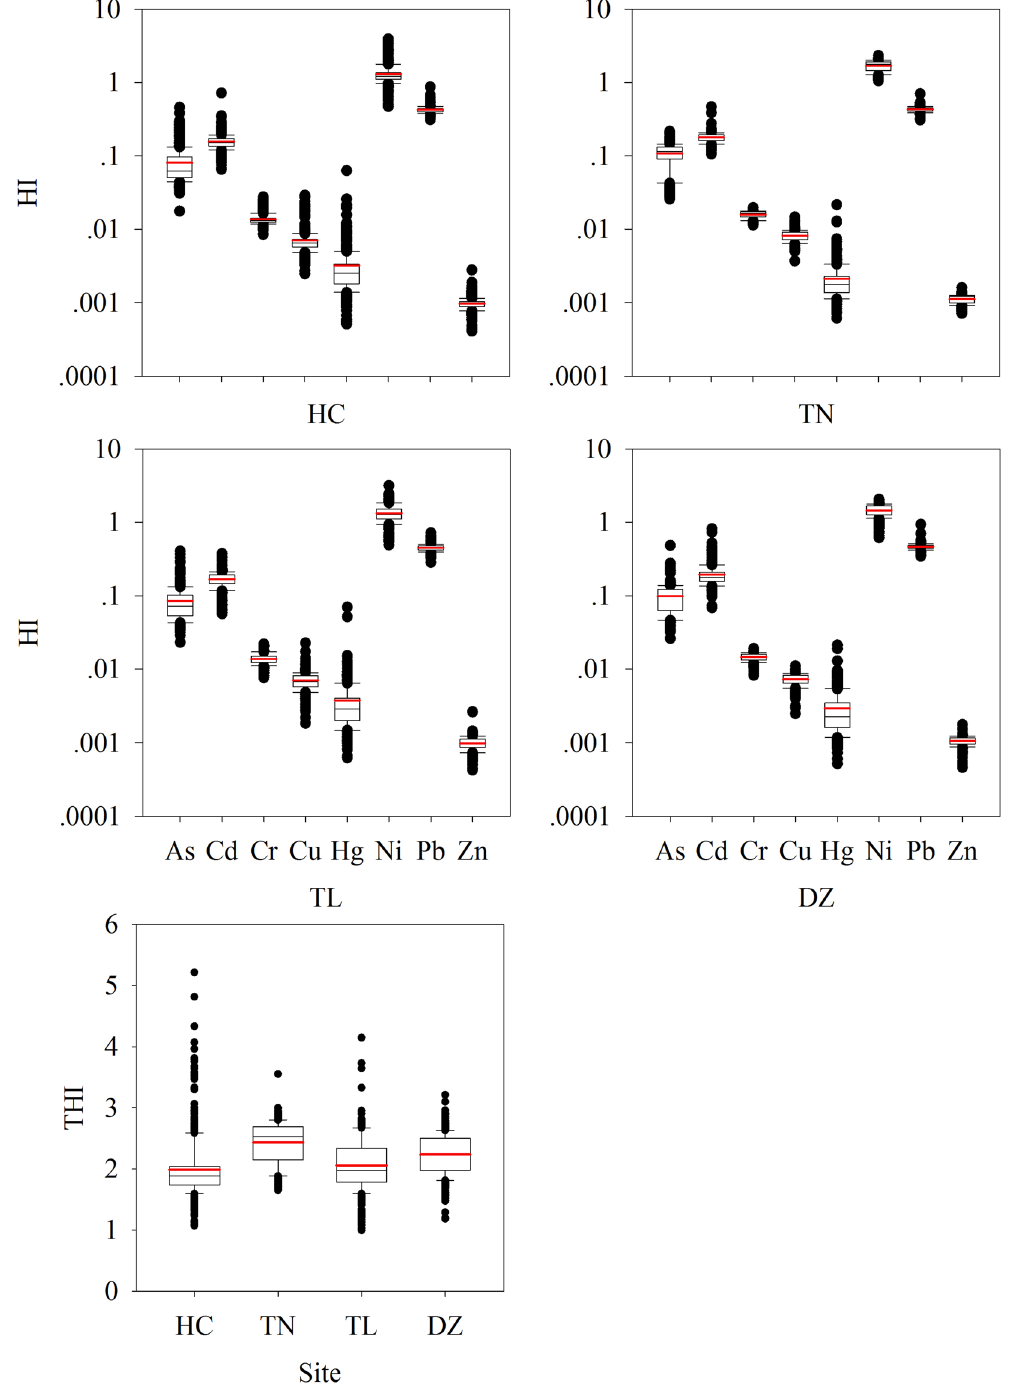
Figure 6. HI for children exposure to HMs in soils of each County (THI for each county showed significant differences, p < 0.001 by Mann-Whitney U text) (symbols for boxplot are similar to Fig.